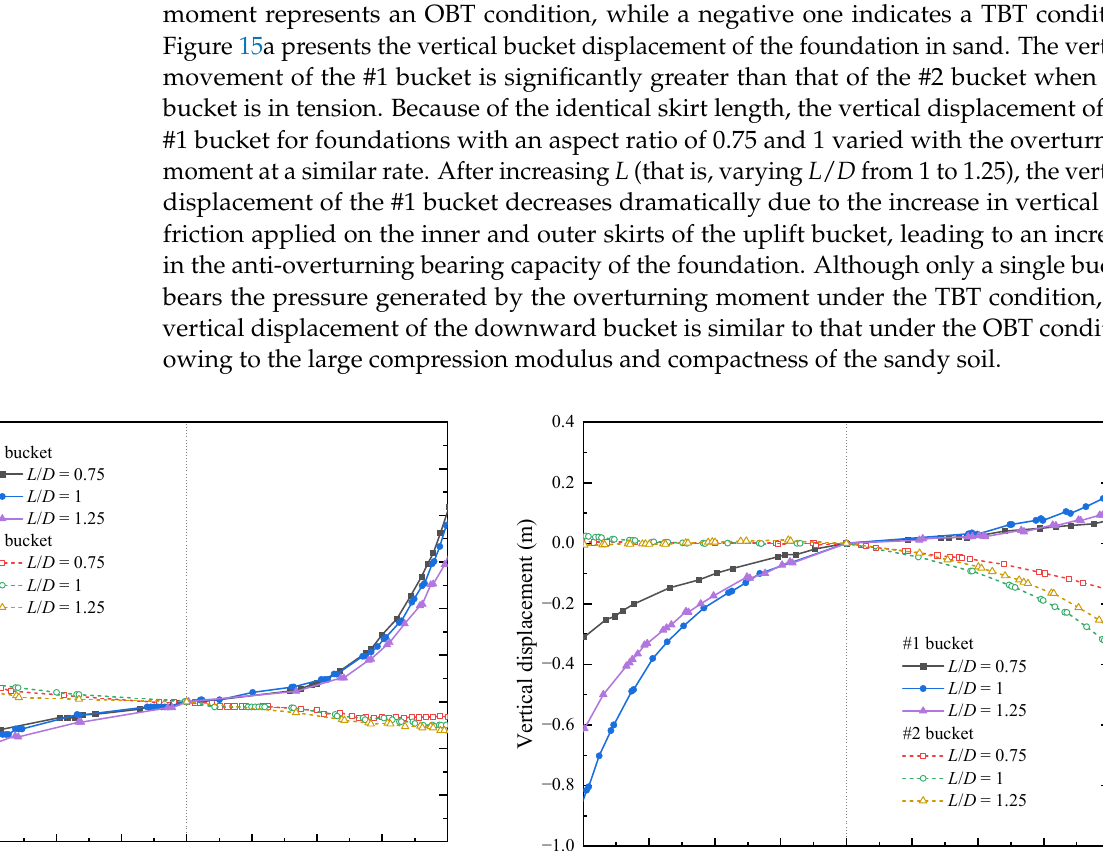
( b ) Figure 14. Anti-overturning bearing characteristic in soft clay: ( a ) moment-rotation response, ( b ) ultimate bearing capacity. It can be seen from Figure 14b that the ultimate bearing capacity of the foundation with L / D = 1.25 under TBT and OBT is 6.6% and 13.7% higher than that with L / D = 1. A